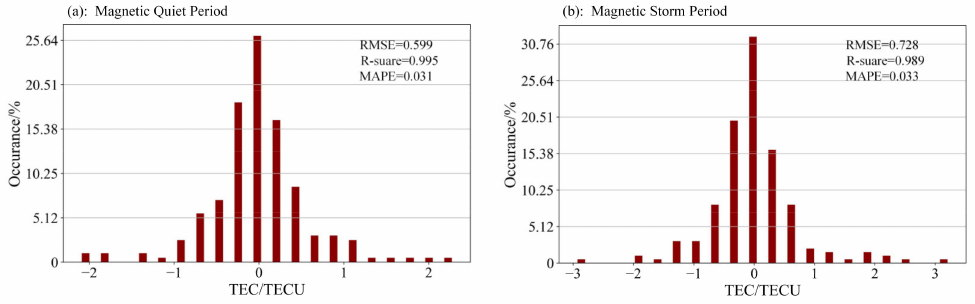
Figure 10. Histograms of absolute error distribution during ( a ) magnetic quiet periods and ( b ) mag- netic storm periods.